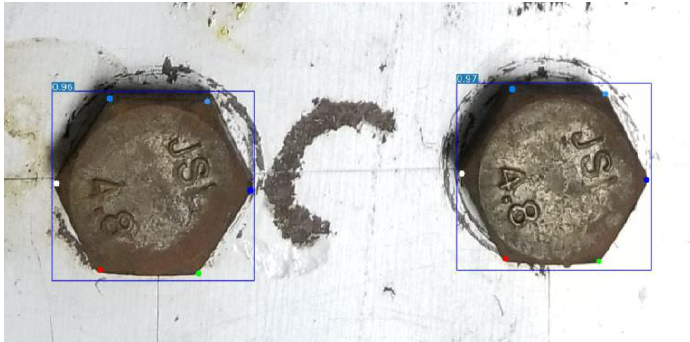
Figure 12. The result of key-point marking and recognition box generation.